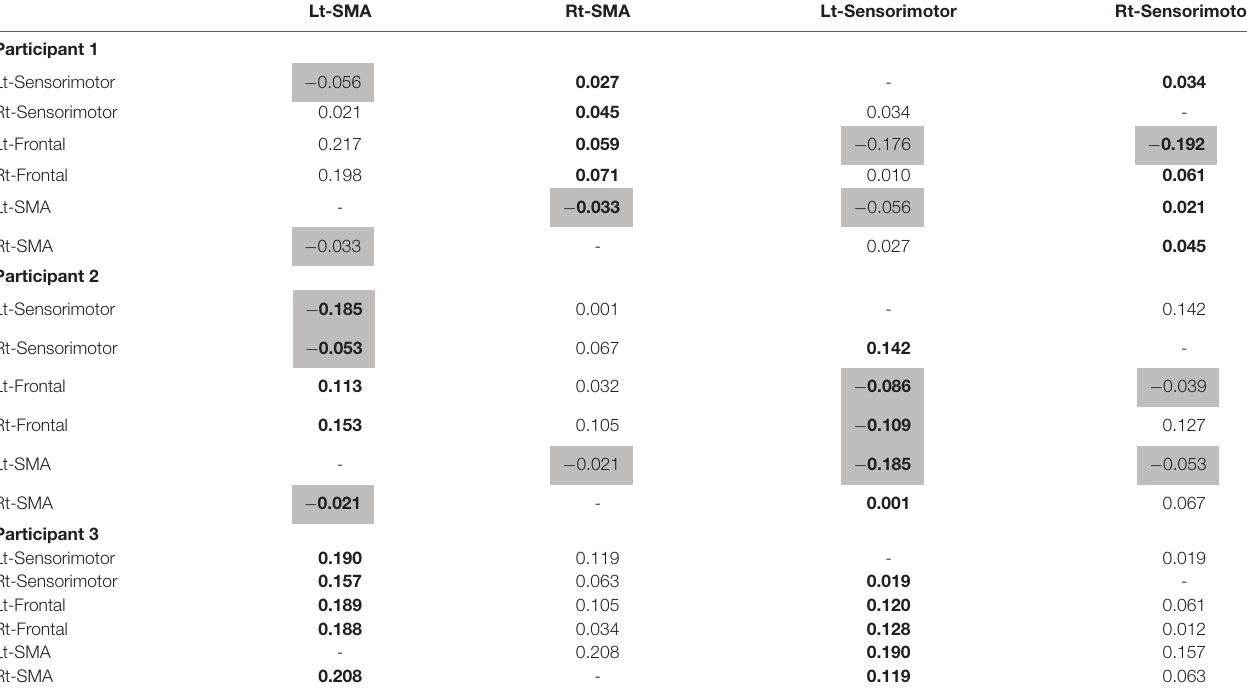
TABLE 2 | Differences in mean AEC value between cortical areas during movement imagery tasks with and without tacit learning system (TLS) activation (movement imagery with TLS activation) − (movement imagery without TLS